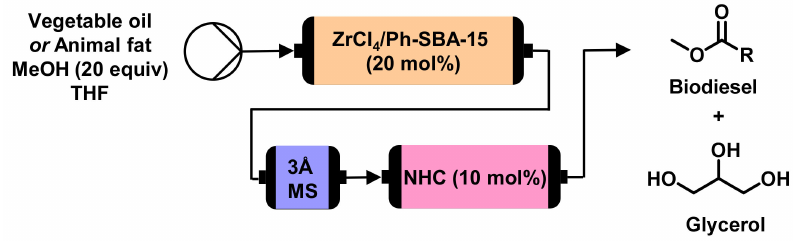
Figure 11. Reactor testing of biodiesel integrated flow